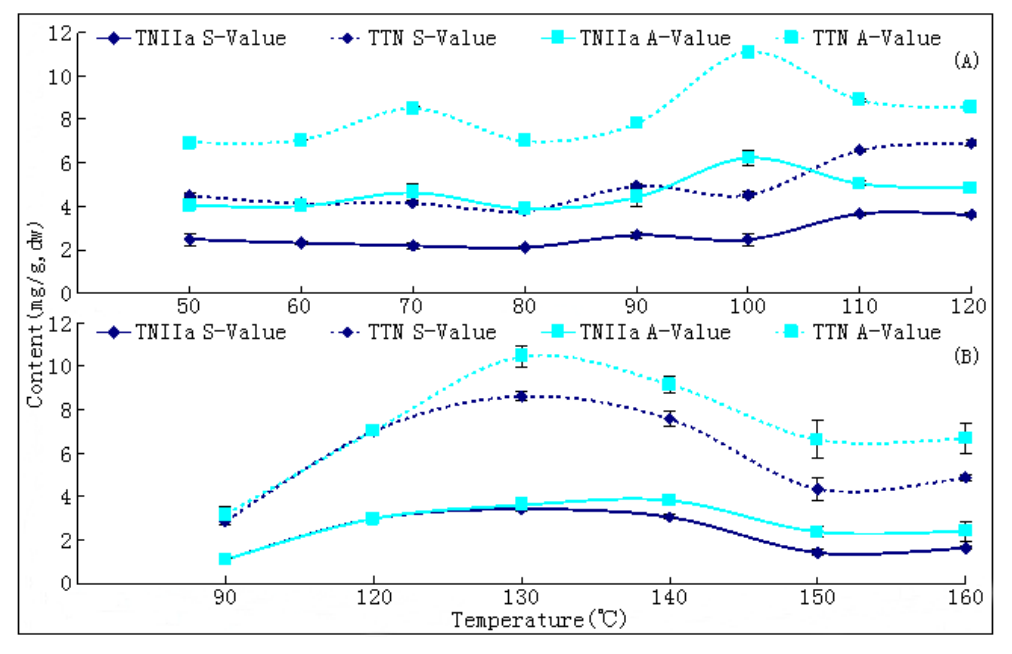
Figure 7. Contents of tanshinones in sufficiently dried samples (S-values) and their apical values (A-values) at different drying temperature. ( A ) results of experiment 1; ( B ) results of experiment 2; Abbreviations: TNIIa (tanshinone IIA); TTN (total